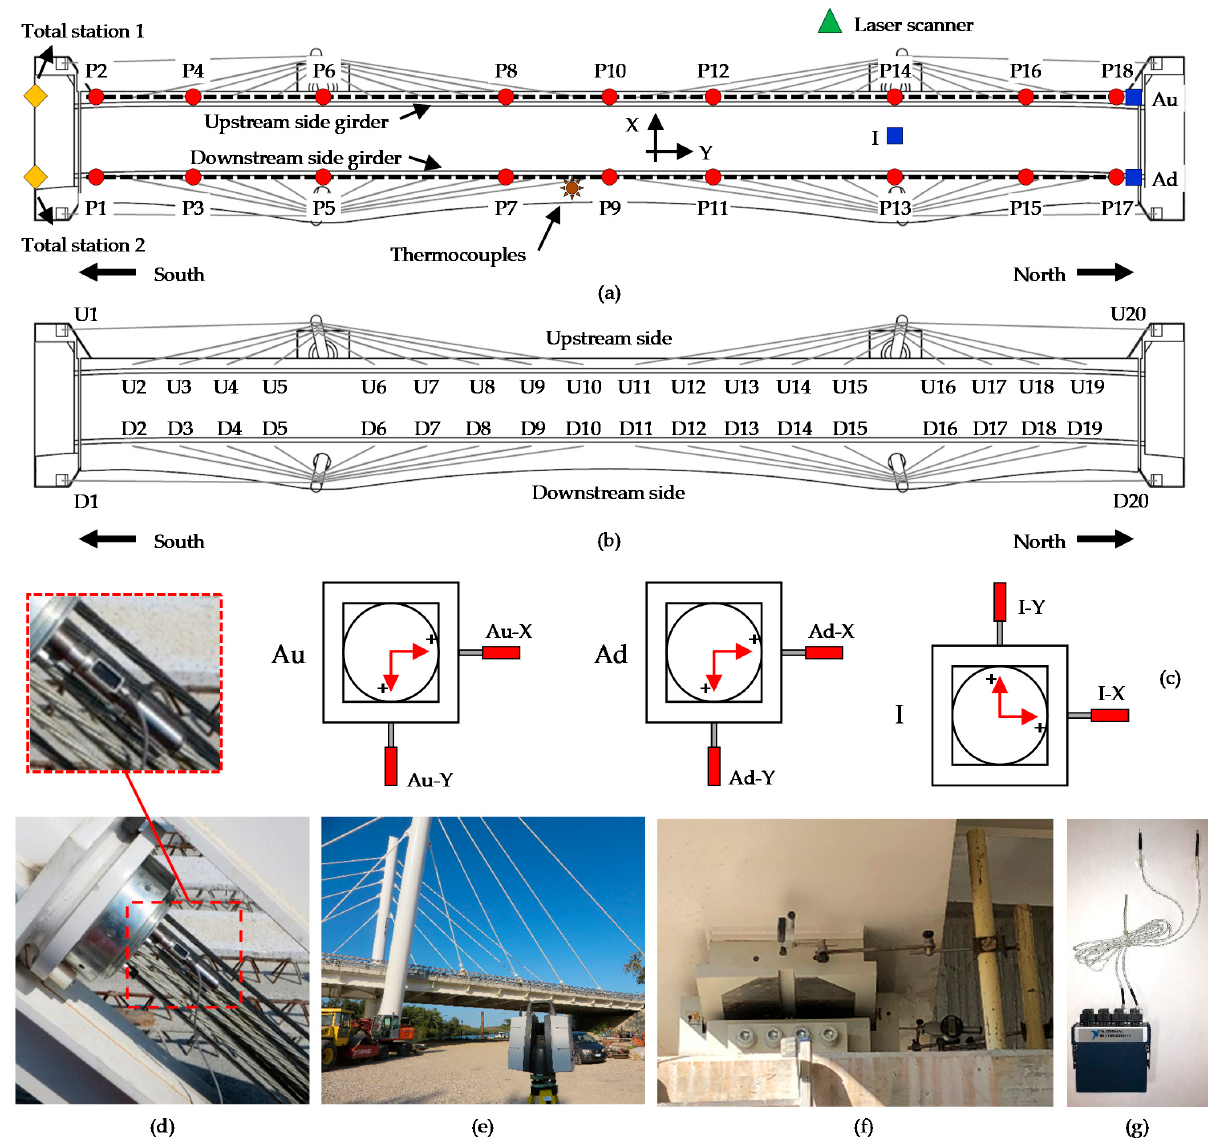
Figure 4. Static proof test instrumentation and sensor arrays: ( a ) layout of measurement points for girder deflections, support displacements and temperature, ( b ) nomenclature of the monitored stays, ( c ) bearing and isolator measurement layout for the horizontal displacements, ( d ) mono-strand load cell, ( e ) laser scanner, ( f ) digital gauges on Au, and ( g ) k-type thermocouples with NI 9219 acquisition